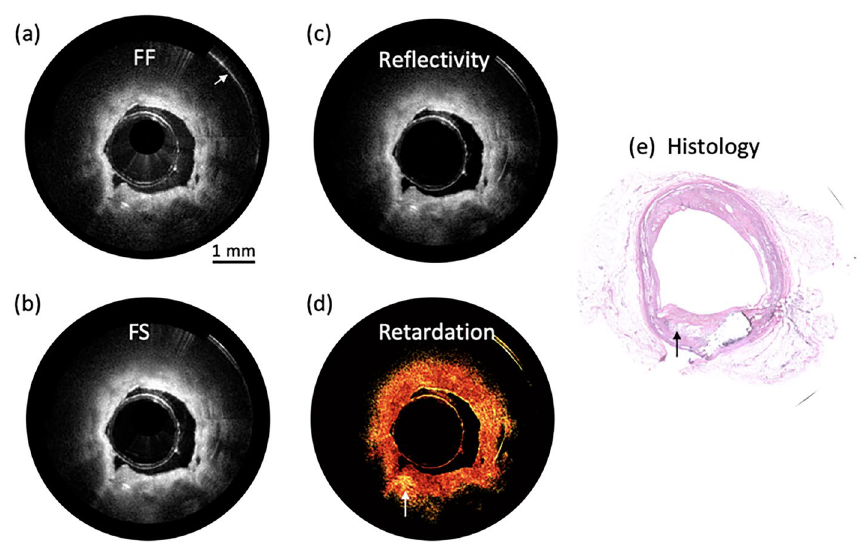
Figure 3. Images of atherosclerotic plaque. ( a ) FF image, ( b ) FS image, ( c ) the normal image of reflectivity, ( d ) the map of sample-field retardation, and ( e ) histology photo. Scale bar: 1 mm. Figures ( a )–( d ) are generated by using Matlab R2021a (Version: 9.10.0.1602886, https:// www. mathw orks. com/ produ cts/ new_ produ cts/ relea se202 1a.